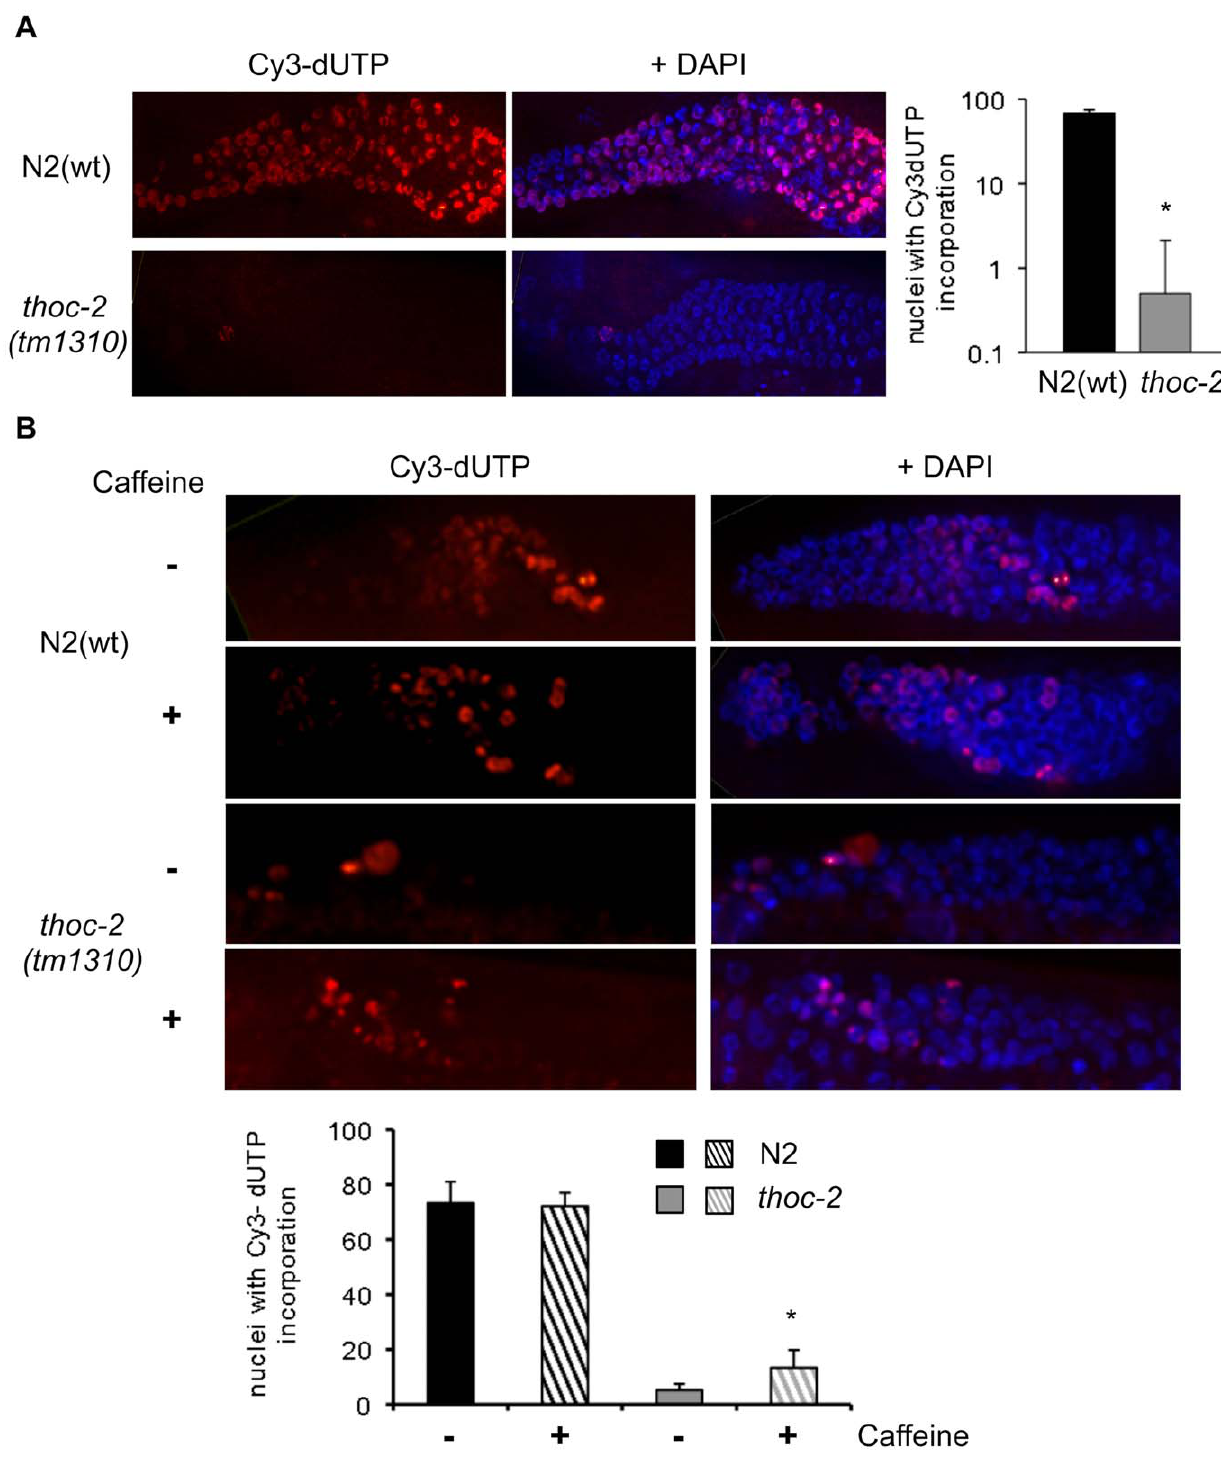
Figure 4. Mitotic replication is impaired in C. elegans thoc-2 germlines and partially alleviated by checkpoint inhibition. ( A ) Representative images of fixed germlines of the indicated genotype of adult hermaphrodites 2.5 hours after microinjection with Cy3-dUTP and quantification of Cy3-dUTP incorporation. Error bars indicate standard error of mean (n=28). Statistically significant differences versus the N2(wt) (p , 0.001) is indicated by an asterisk * (Student’s t-Test). ( B ) Representative images of fixed germlines of the indicated genotype of adult hermaphrodites after microinjection with Cy3-dUTP with or without caffeine and quantification of Cy3-dUTP incorporation. Statistically significant differences versus untreated (p , 0.001, n=15) is indicated by an asterisk * (Student’s t-Test).